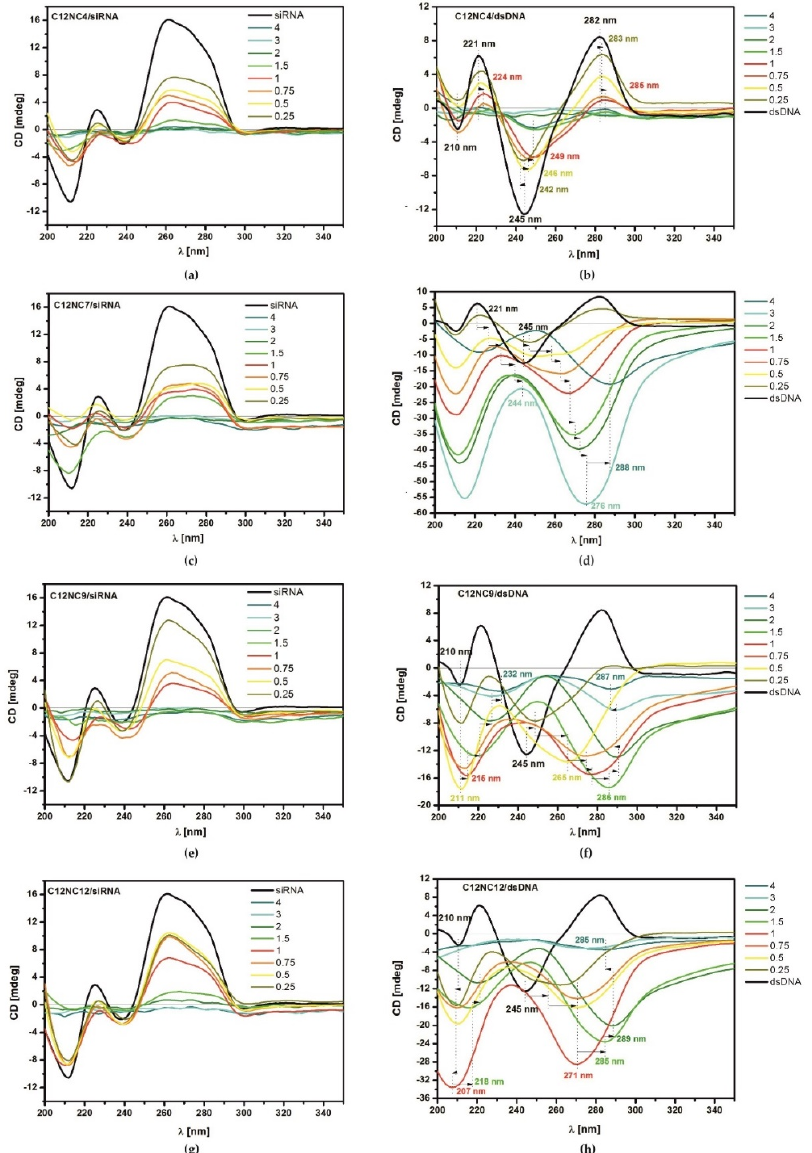
Figure 4. Circular dichroism results obtained for selected tested mixtures of C12NCn with siRNA ( a , c , e and g ) and dsDNA ( b , d , f and h ). The strongest signal which can be assigned to the Ψ-DNA phase was observed for C12NC7 for p/n = 3 ( d ).